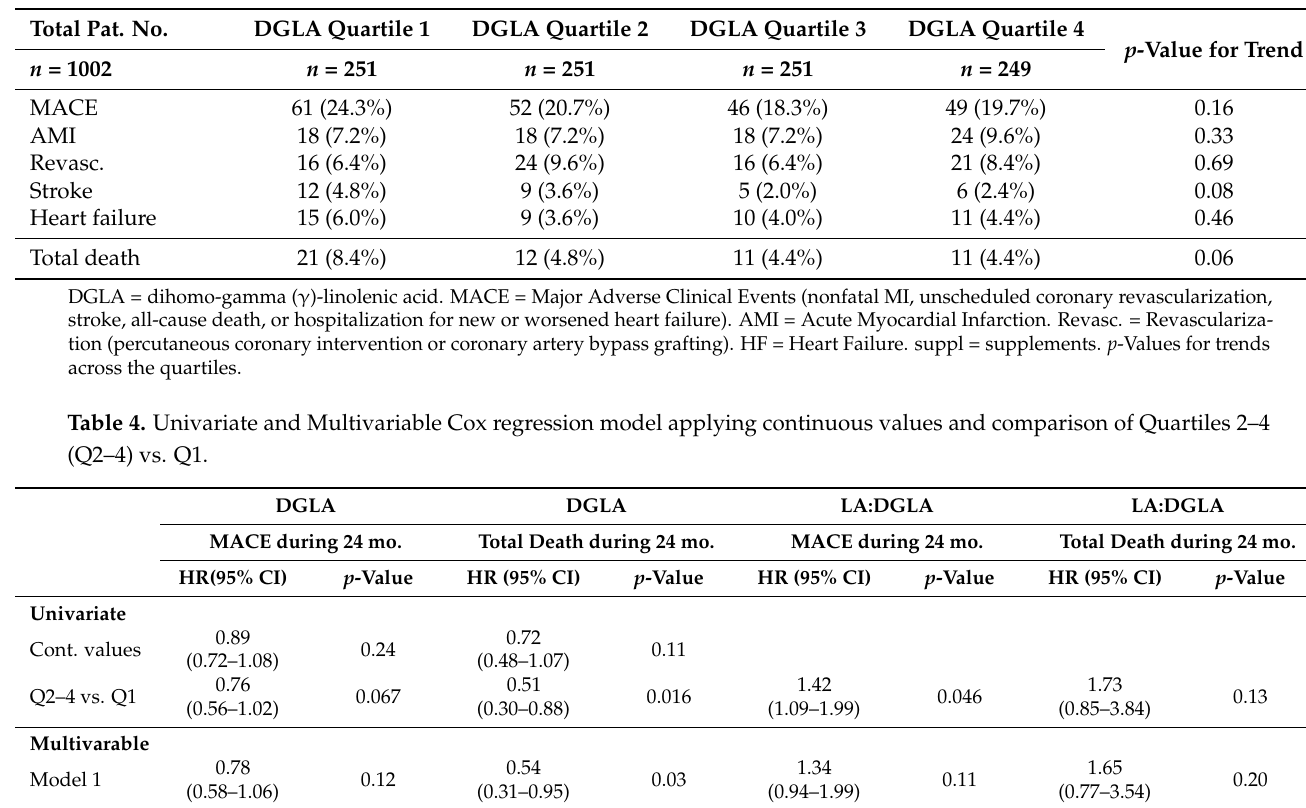
Abbreviations: MACE = Major Adverse Clinical Events. Model 1: Adjusting for age, sex and BMI. Model 2: Adding cod liver oil supplementation at baseline to the model. Model 3: Adding hypertension, chronic kidney disease (CKD) and diabetes mellitus to the former